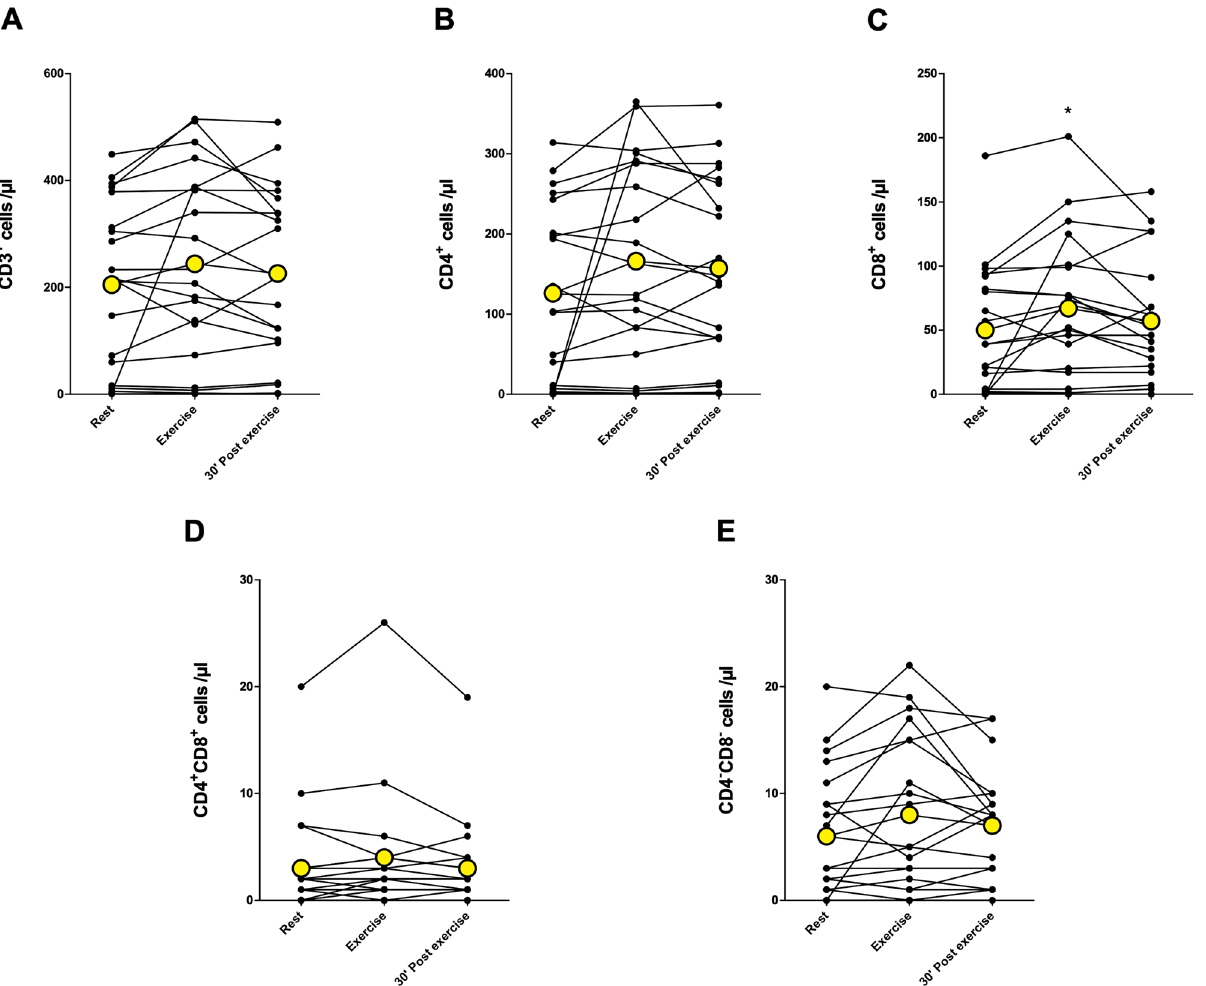
Figure 3. The number of T cells at rest, immediately after and 30 min after acute exercise. The number of ( A ) total T cells (CD45 + CD3 + ) or the number of ( B ) helper T cells (identified as CD45 + CD3 + CD4 + cells) did not change. The number of ( C ) cytotoxic T cells (identified as CD45 + CD3 + CD8 + cells) increased significantly immediately after exercise. The number of ( D ) double positive T cells and the number of ( E ) double negative T cells (identified as CD45 + CD3 + CD4 − CD8 − cells remained unchanged. Yellow points represent the mean. * p < 0.05 between rest and